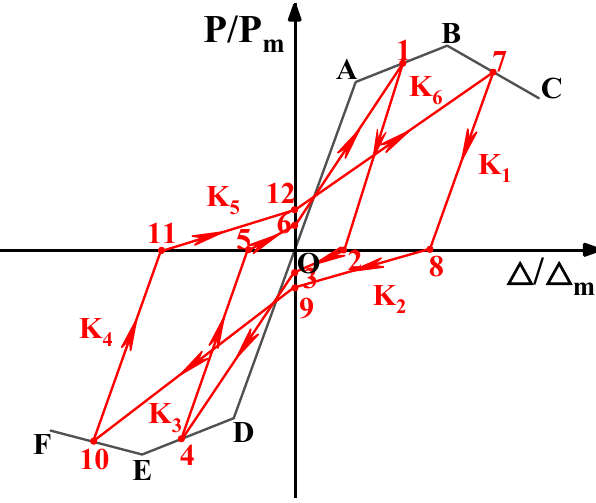
Figure 14. Hysteresis Rules.